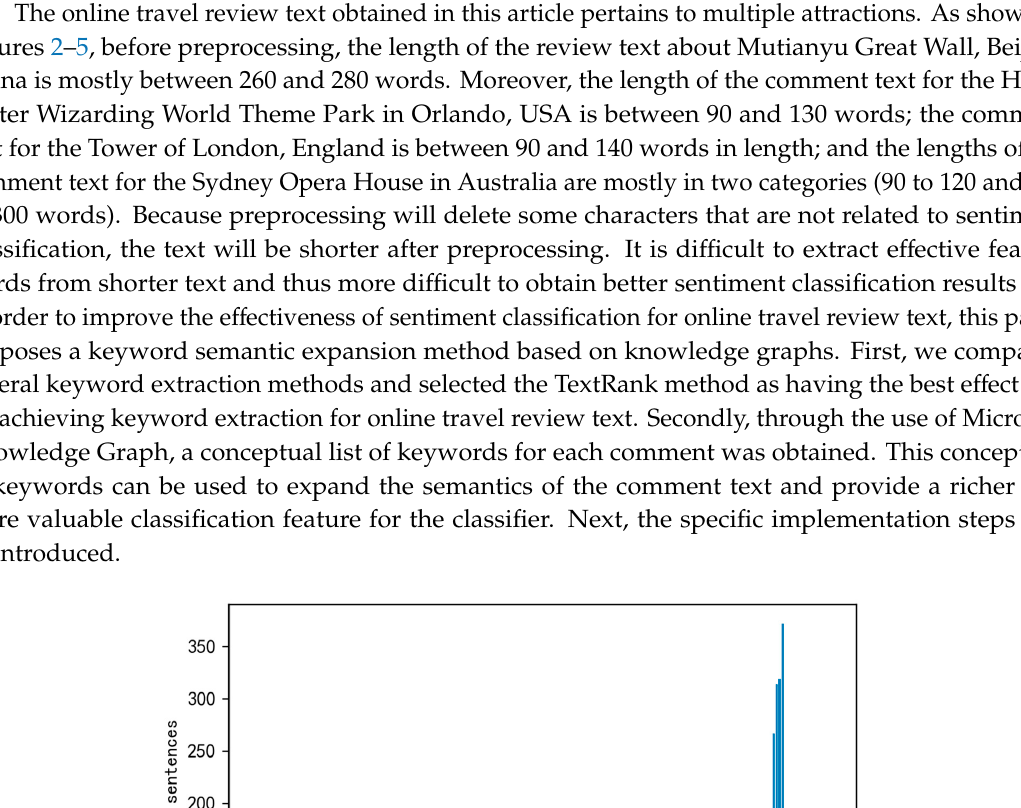
Figure 4. Length of the comment text of the Tower of London.